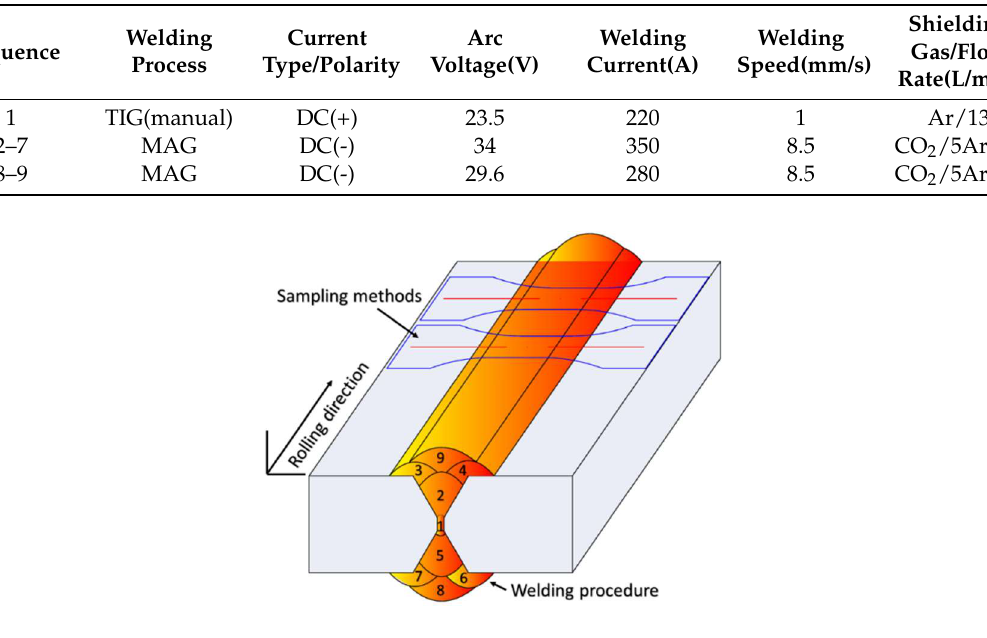
Figure 10. Welding process and sampling method.